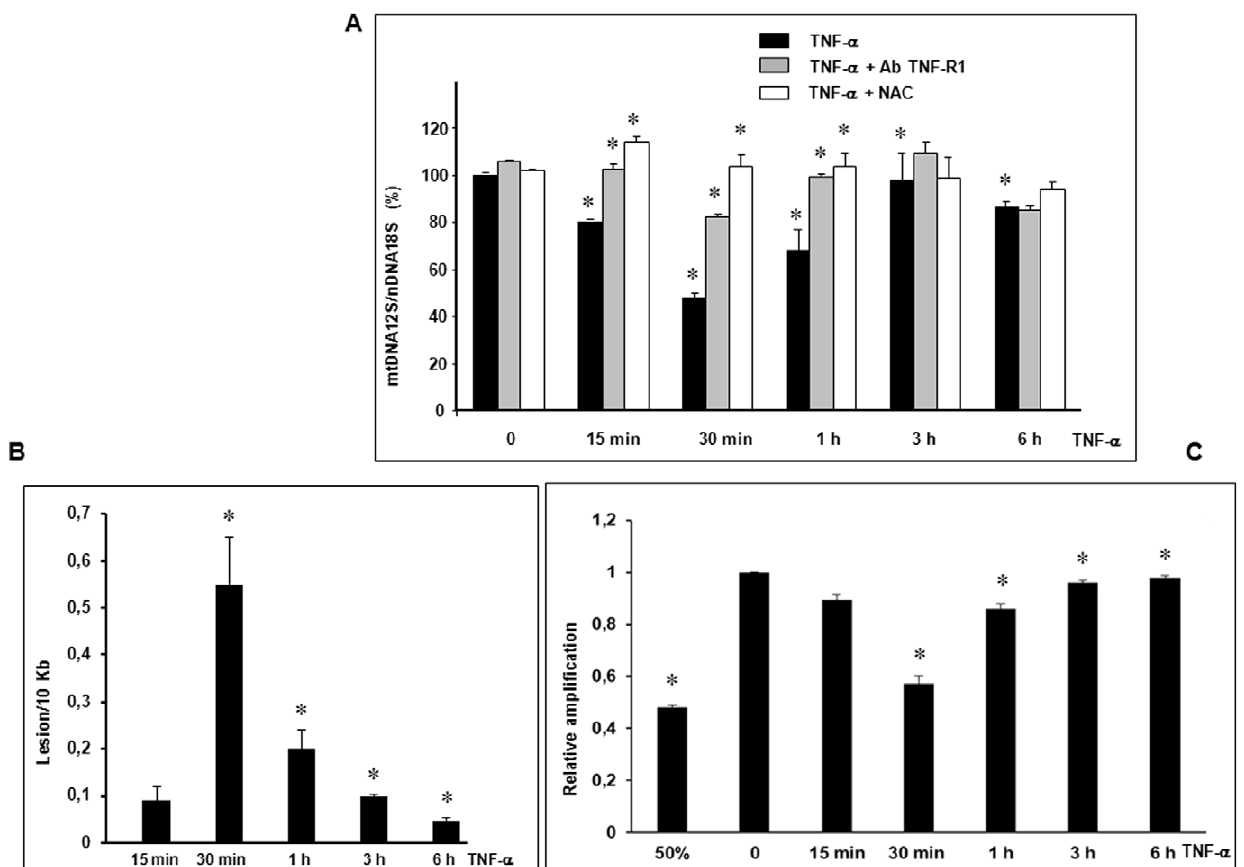
Figure 2. TNF- a induced mtDNA depletion, lesions and repair. (A) Cells were pretreated or not (TNF- a ) for 1 h with 1 m g/ml TNF-R1 antibody (TNF-R1 Ab) or with 5 mM NAC. They were then treated for 0 to 6 h with 30 ng/ml TNF- a . To evaluate mtDNA depletion, total genomic DNA was isolated and quantification of mtDNA performed by simultaneous real-time qPCR amplification of fragments encoding mitochondrial 12S rRNA and nuclear 18S rRNA used as a reference gene. Results are expressed in 12S mtDNA over 18S nDNA relative ratio (mean values 6 SEM of four independent experiments with four replicates, *p , 0.05). (B) mtDNA lesions per 10 Kb were quantified by qPCR amplification of a large fragment (8.9 Kb) from cells treated or not for 15 min-6 h with 30 ng/ml TNF- a and expressed using the Poisson expression [27] (mean values 6 SEM of three independent experiments with three replicates, *p , 0.05). (C) mtDNA repair activity was measured by calculating relative amplification comparing the values of the treated samples with undamaged control [27], a 50% mtDNA control has been performed (mean values 6 SEM of three independent experiments with three replicates, *p , 0.05).